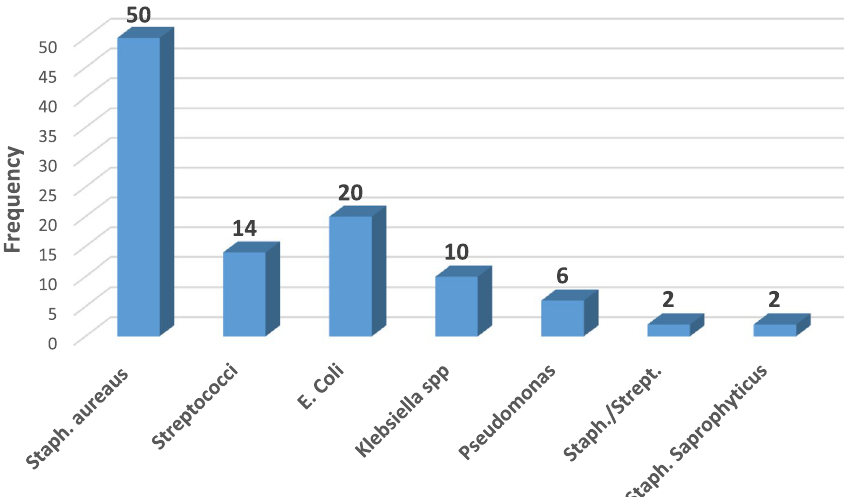
Fig. 2 Specific organisms cultured